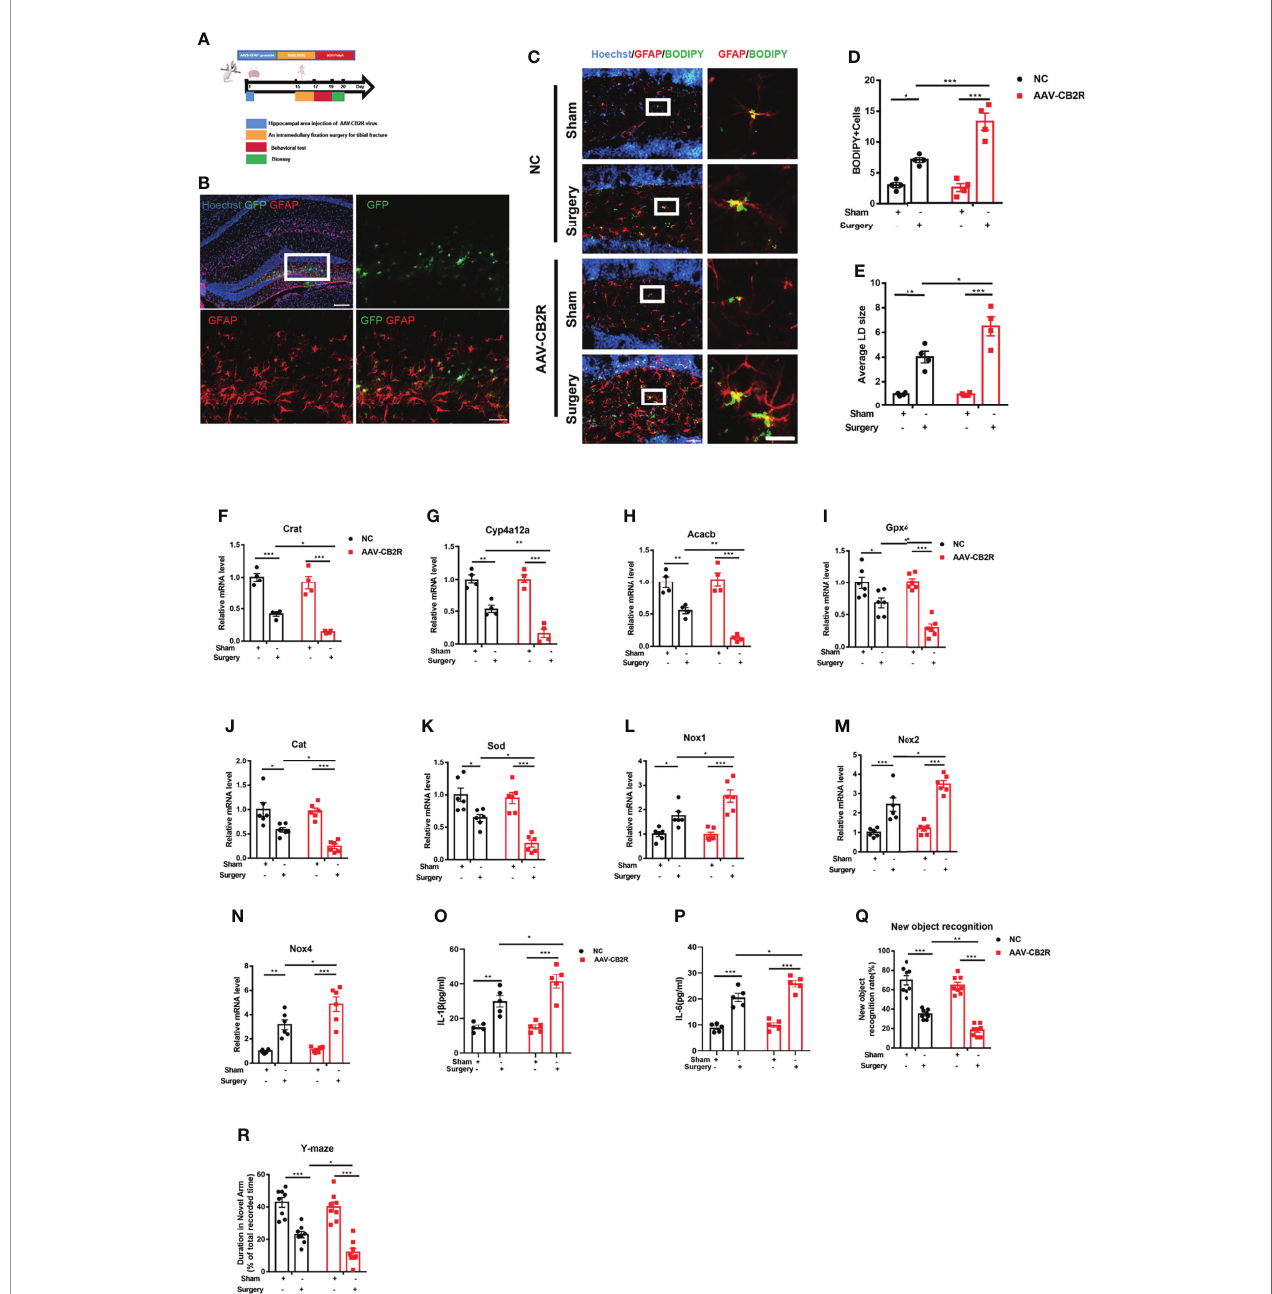
FIGURE 2 | (A) Experimental protocol and timeline. Injection with the AAV virus in the hippocampus of mice 2 weeks before surgery; behavioral and biological testing 2 d after surgery. (B) Immuno fl uorescence staining of GFAP and AAV virus – GFP staining in the hippocampal DG brain region. (C – E) Immuno fl uorescence staining of GFAP and BODIPY staining in the hippocampal DG brain region; statistical data on BODIPY+ cells and the average LD size (means±SEM, n=4, scale bars=40 and 3 m m). (F – N) RT- qPCR results of the relative mRNA expression levels of Crat, Cyp4a12a, Acacb, Gpx4, Sod, Cat, and Nox1,2,4 in the hippocampus (means±SEM, Crat, Cyp4a12a, Acacb, n=4; Sod, Cat, and Nox1,2,4 n=6). (O, P) ELISA of serum IL-1 b and IL-6 (n=5). (Q, R) New object recognition and Y-maze testing of mice in each group (means±SEM, n =10). * P < 0.05, ** P < 0.01, *** P < 0.001 compared with the corresponding group, as determined by two-way ANOVA, F (1, 12) BODIPY Cells Interaction =17.22; F (1, 12) LD size Interaction =7.598; F (1, 12) Crat Interaction =2.169;F (1, 12) Cyp4a12a Interaction =8.219; F (1, 12) Acacb Interaction =9.162;F (1, 20) Gpx4 Interaction =7.022;F (1, 20) Cat Interaction =3.355;F (1, 20) Sod Interaction =4.956;F (1, 20) Nox1 Interaction =6.025;F (1, 20) Nox2 Interaction =4.125;F (1, 20) Nox4 Interaction =4.494;F (1, 16) IL-1 b Interaction =4.600;F (1, 16) IL-6 Interaction =3.384; F (1, 28) New ’ s post hoc object recognition Interaction =3.258;F (1, 28) Y-maze Interaction =2.318, followed by Tukey